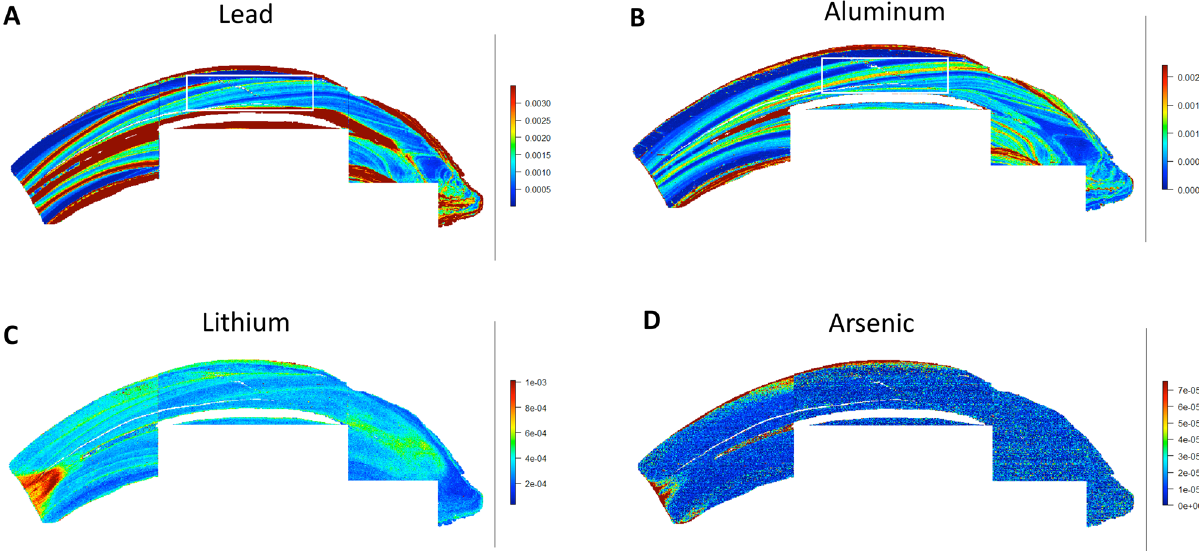
Figure 2. Toxic elements in equine teeth. Maps for lead ( A ), aluminum ( B ), lithium ( C ) and arsenic ( D ) are shown. Banding patterns are evident for lead and aluminum maps (i.e. alternating interspersed zones of